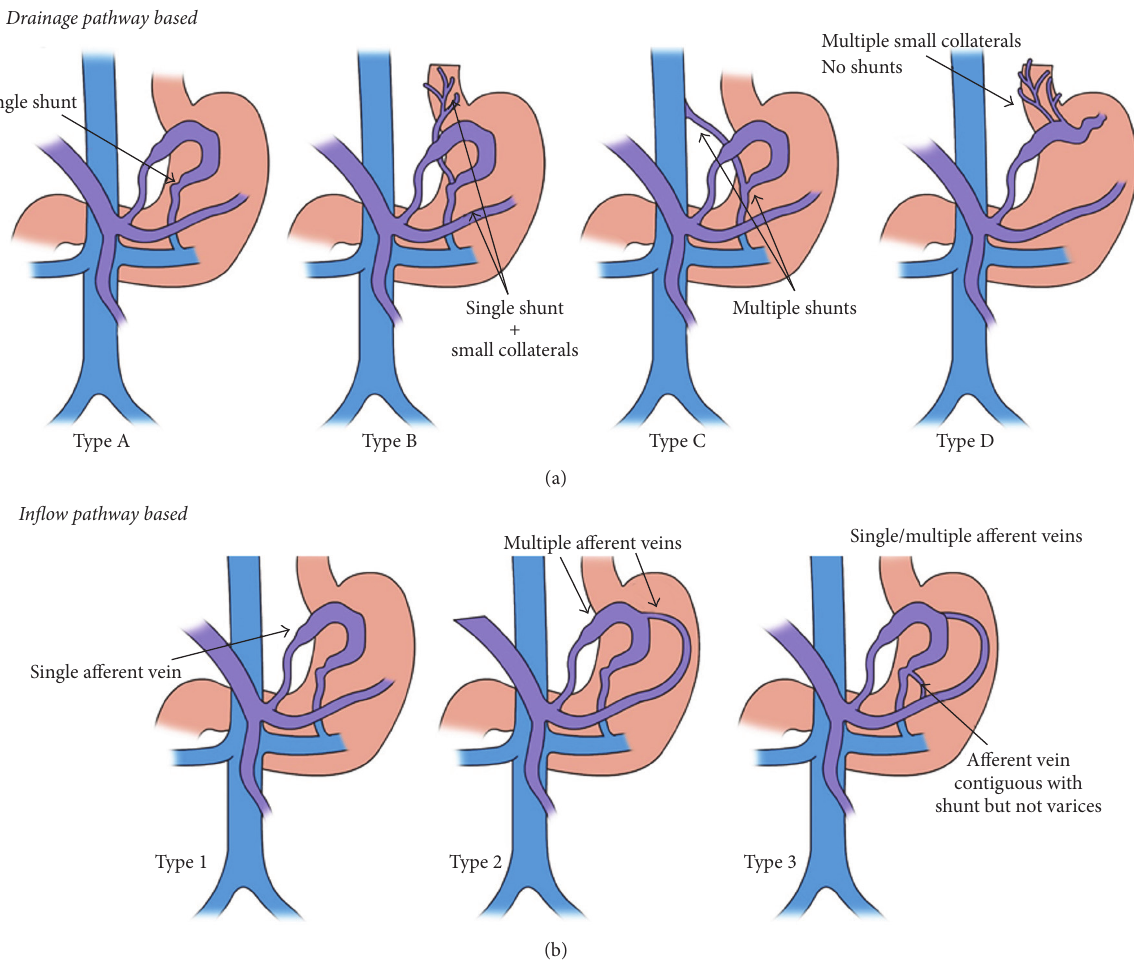
Figure 4: The Kiyosue classification of gastric varices. (a) Classification based on drainage pathway. Type A consists of a portosystemic shunt as the only drainage; Type B portosystemic shunts along with additional small portosystemic collaterals; in Type C, there is presence of multiple large portosystemic shunts; and Type D consists of multiple small portosystemic collaterals as the drainage pathways without proper shunt formation. (b) Classification based on the inflow pathway: Type 1 consists of single afferent vein for the varices; Type 2 has multiple afferent vessels contributing to the variceal formation; Type 3 is similar to Type 2 but with additional small collateral/shunts directly communicating with outflow tract. Modified and redrawn from